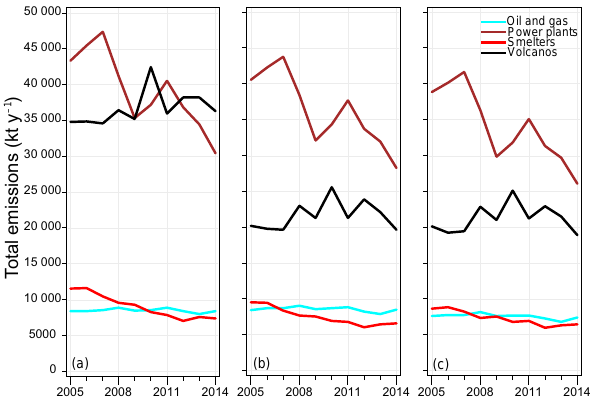
Figure 12. Total annual emissions by source type: power plants, smelters, sources related to the oil and gas industry, and volcanic sources. Emissions were calculated using constant AMF = 0.36 (a) , an AMF value that depends on the site altitude only (b) , and an AMF value that was calculated using the site altitude, albedo, and the PBL height (c) .